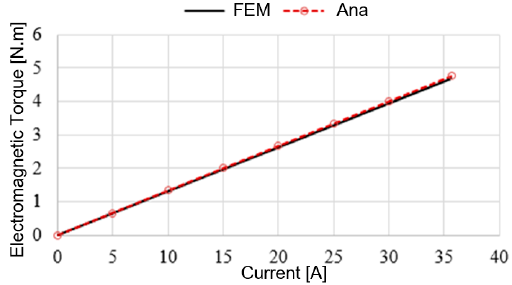
Figure 21. Torque under different loading conditions.